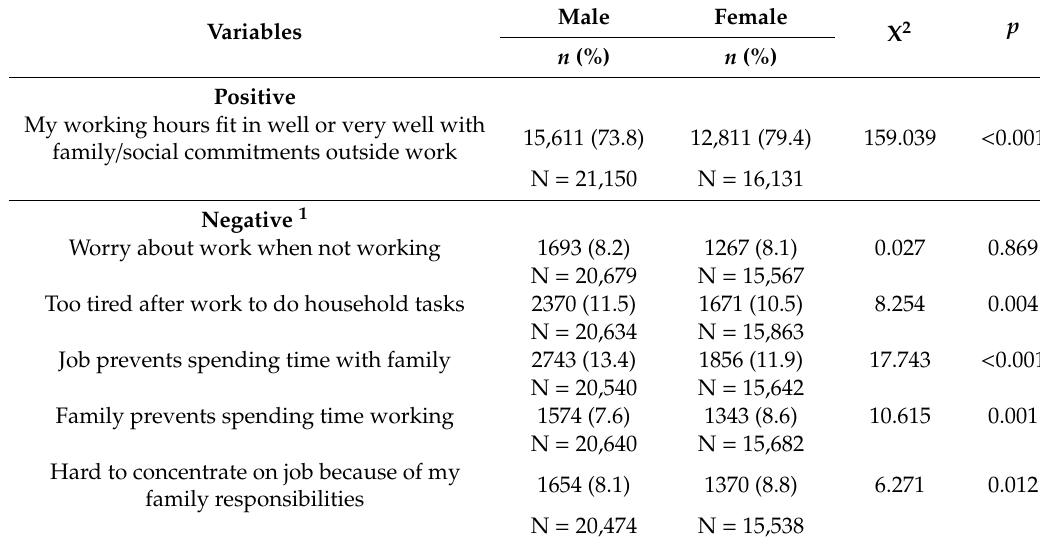
Table 3. Comparison of work–life balance by